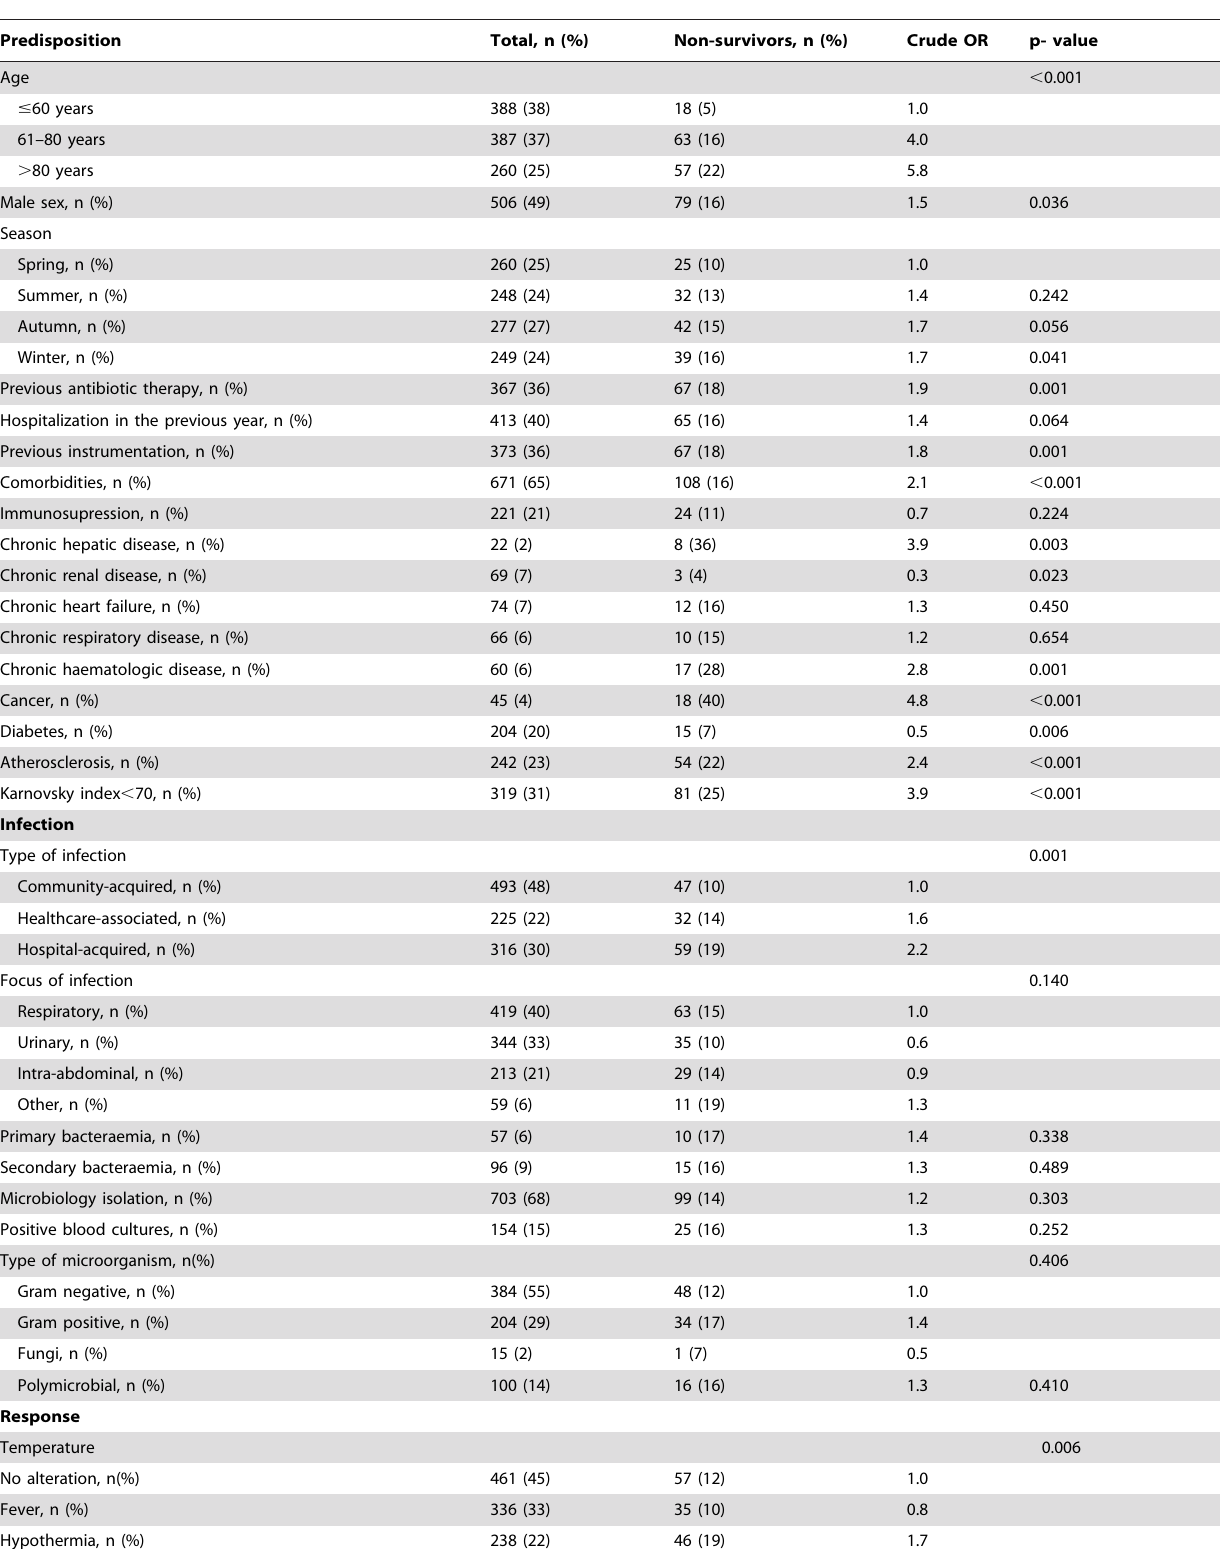
Table 2. Association of variables of each of the four components of PIRO with hospital mortality using logistic regression. Characteristics of the patients included in the study according to the four components of the PIRO concept.